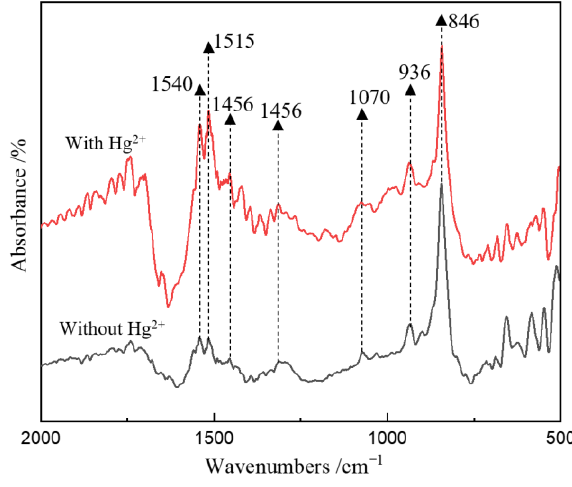
Figure 6. FT-IR spectra of the solid particulate at day 48 for the groups without and with Hg 2+ .